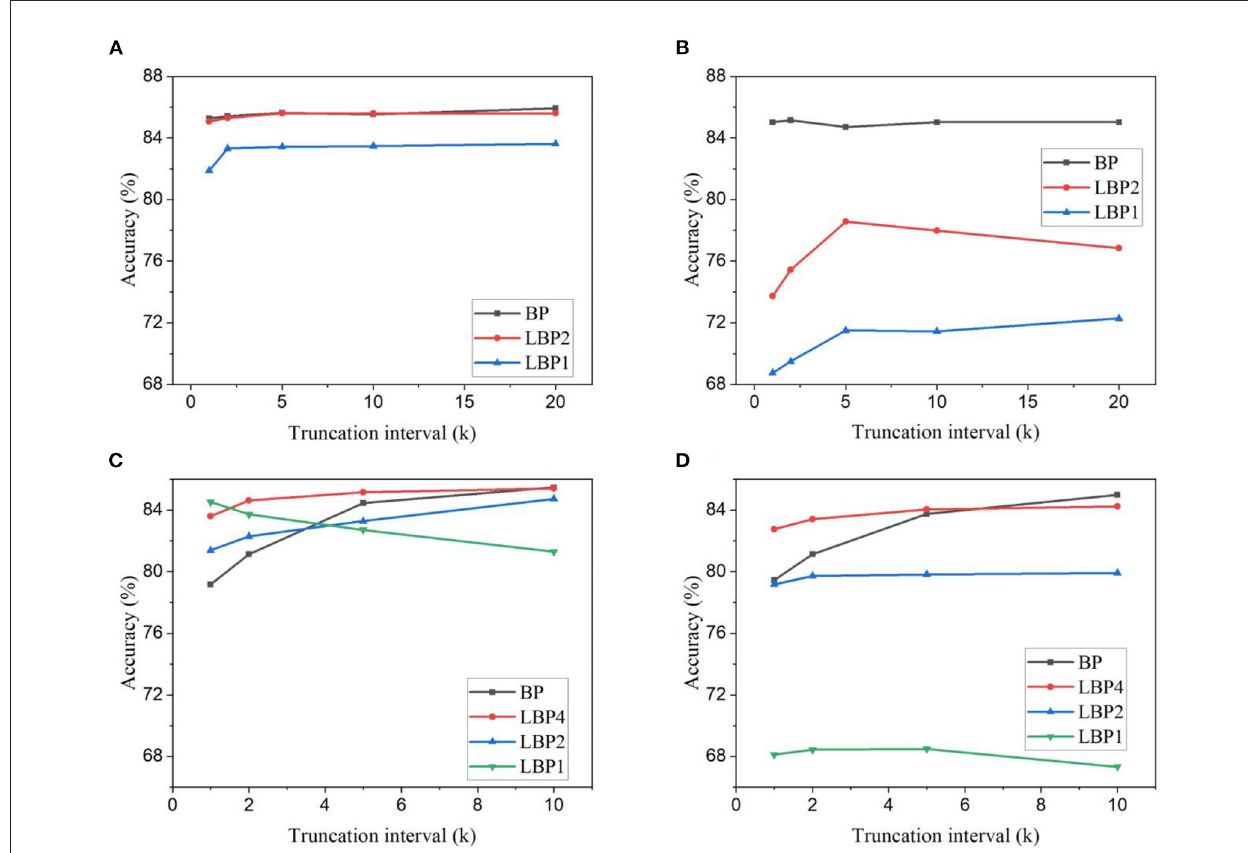
FIGURE3 Classification accuracy for different truncation intervals and local block size. Accuracy results are obtained for LeNet-1 on EMNIST dataset with (A) trainable classifiers and (B) random classifiers. And accuracy results are obtained for AlexNet on CIFAR10 dataset with (C) trainable classifiers and (D) random classifiers. In LBPn, n indicates the number of layers in a local